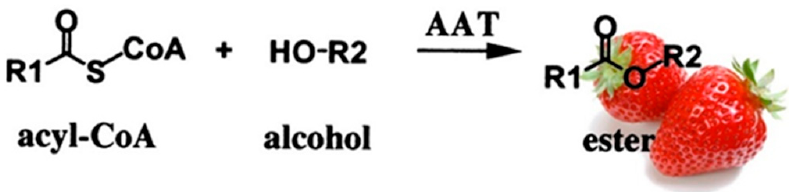
Figure 4. Schematic representation of the esterification reaction catalyzed by the alcohol acyltrans- ferase (ATT).